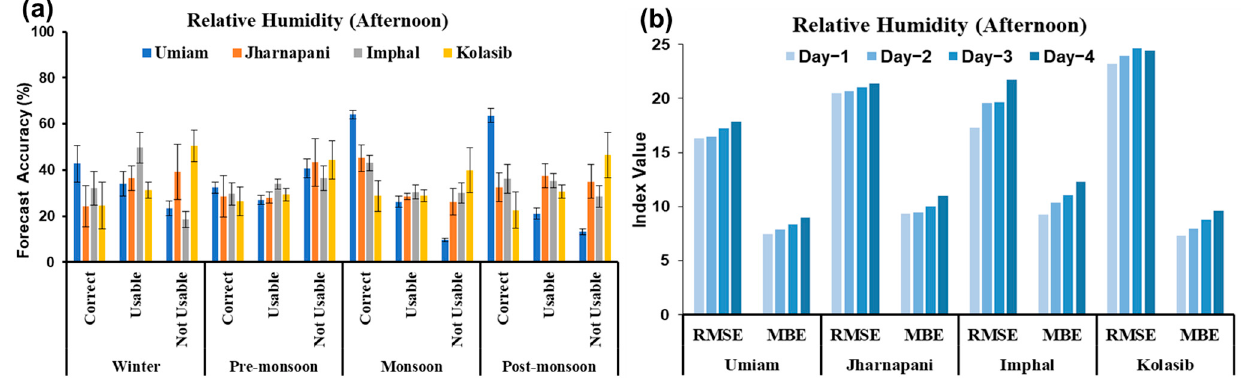
Figure 5. Quantitative ( a ) and statistical evaluation ( b ) of RH (afternoon) forecast over various locations of the northeastern hill region of India.